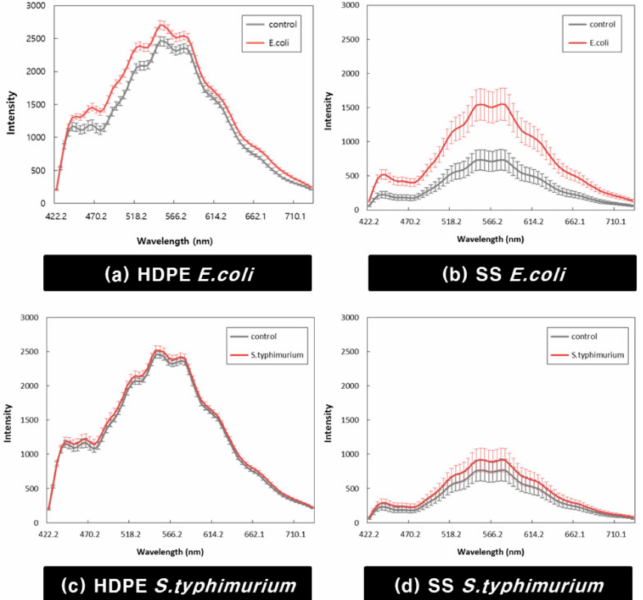
Figure 8. Average spectra of extracted pixel spectra from hyperspectral images: ( a ) E. coli cultivated on HDPE, ( b ) E. coli cultivated on SS, ( c ) S. typhimurium cultivated on HDPE, and ( d ) S. typhimurium cultivated on